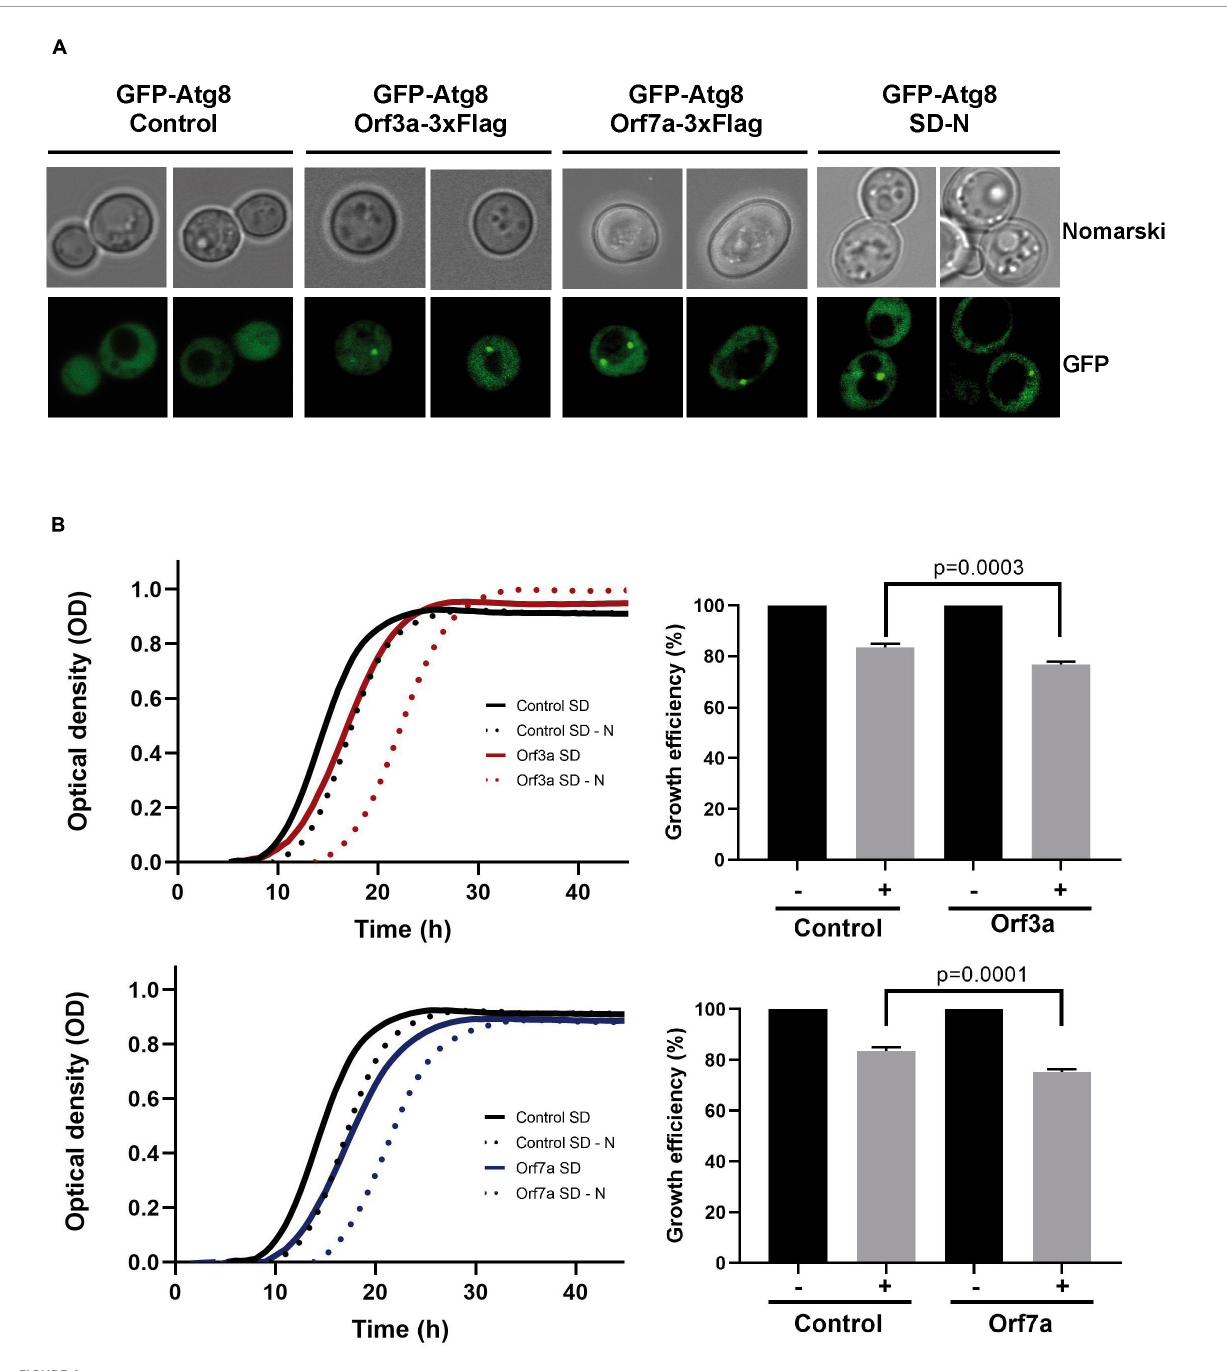
FIGURE4 Overexpression of severe acute respiratory syndrome coronavirus-2 (SARS-CoV-2) ORF3a and ORF7a leads to accumulation of Atg8-positive autophagosomes and sensitivity to starvation. (A) The formation of autophagosomal structures was visualized by the expression of GFP-tagged Atg8 in yeast wild type cells in the absence (empty vector control) or the presence of constitutively overexpressed Orf3a-flag or Orf7a-flag as indicated. Cells were grown to exponential phase in SD medium or incubated over night in SD-N medium for starvation induction. Representative micrographs are shown for each genetic background and treatment. (B) SARS-CoV-2 ORF3a (upper panel) and ORF7a (lower panel) were constitutively overexpressed as flag fusion proteins in yeast wild type cells and the growth continuously monitored in SD medium. Cells were either directly diluted from SD medium (-starvation) or after 3 days in SD-N medium (+starvation). Control cells contain the empty plasmid. Right panels: Representation of the relative growth efficiency. Growth of the non-starved cells was set to 100%. Three independent biological samples were analyzed. Data are mean ± SD. P -values indicate significant differences between control and overexpressor cells according to the unpaired Student’s t -test.